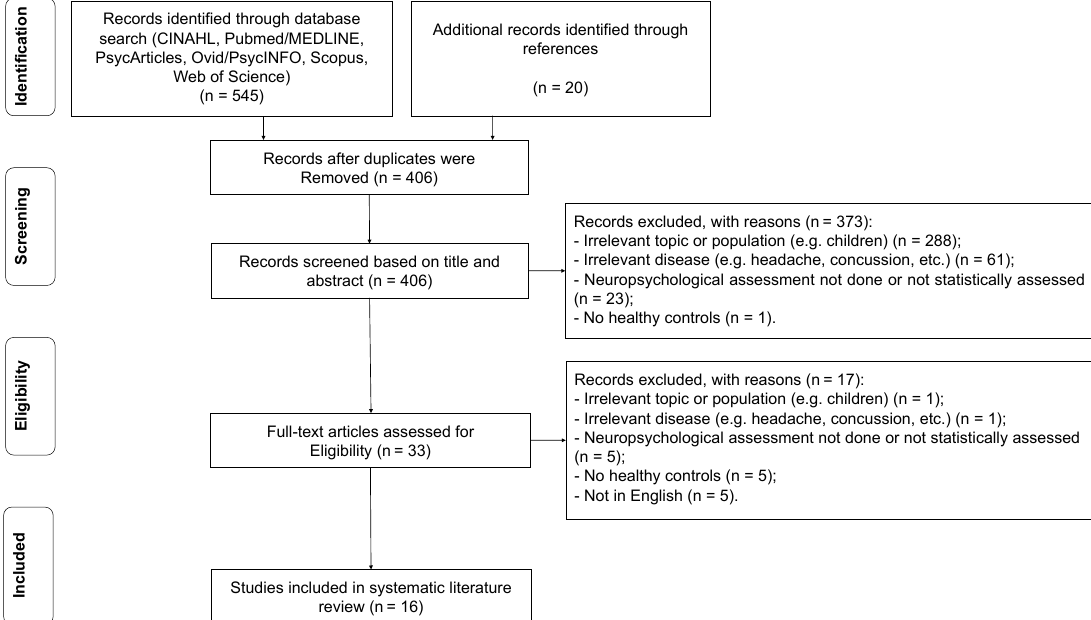
Figure 1. PRISMA flowchart of the systematic literature